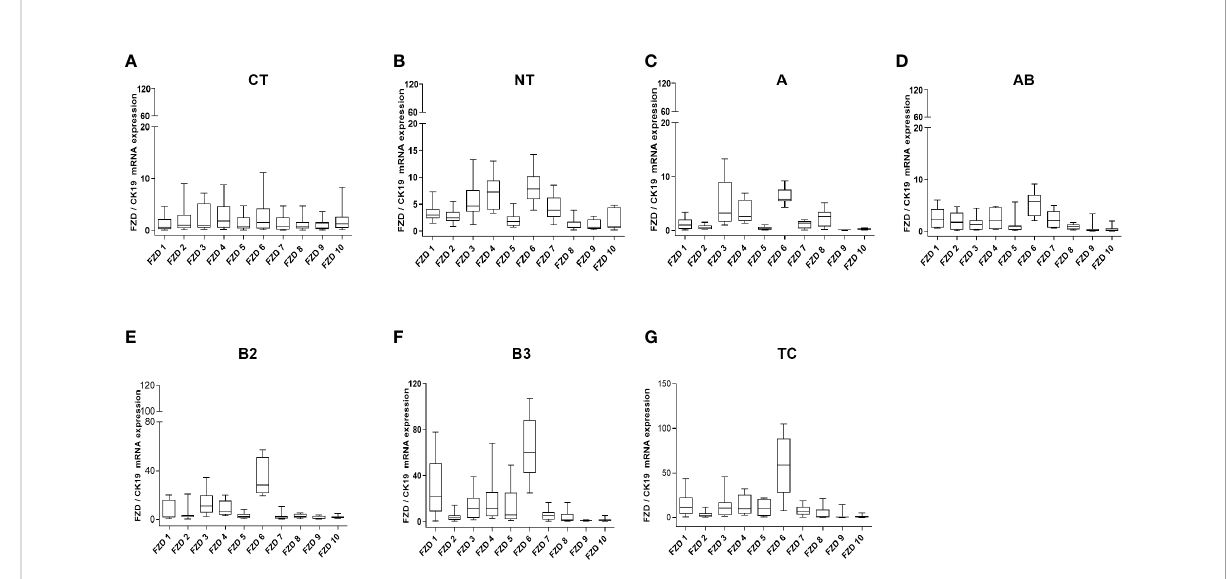
FIGURE 3 WNT frizzled receptor mRNA expression analysis. mRNA expression of 10 FZD receptors by Q-PCR in normal thymuses and TETs: (A) : 1 to 10 years old childhood thymuses (n = 6); (B) : adult thymuses (n = 15); (C) : thymoma type A (n = 9); (D) : thymoma type AB (n = 23); (E) : thymoma type B2 (n = 18); (F) : thymoma type 3 (n = 18) and (G) : thymic carcinoma (TC, n = 11). Cytokeratin 19 was used as reference gene to take the variable content of non-neoplastic thymocytes and WNT-producing thymic epithelial cells in the various thymomas into account.